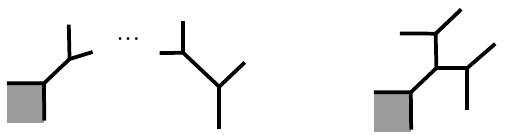
Figure 14 . The non-compact toric divisor where a single D4 is supported for generalized conifolds and C 3 / ( Z Z ) 2 × 2